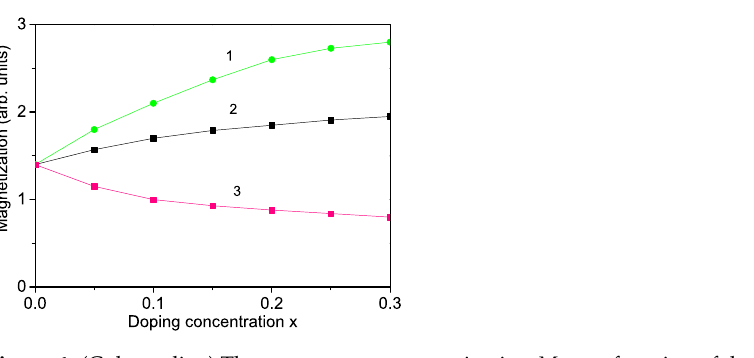
Figure 4. (Color online) The spontaneous magnetization M s as a function of the doping concentration of a (1) Co-doped (with J d = 1.4 J b ), (2) Er-doped (with J d = 1.2 J b ) and (3) Ti-doped (with J d = 0.8 J b ) YFO nanoparticle for T = 300 K and N = 10 shells.